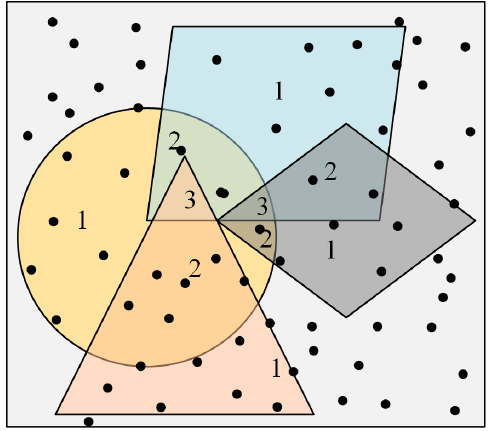
Figure 8. Random sampling by Monte Carlo method.